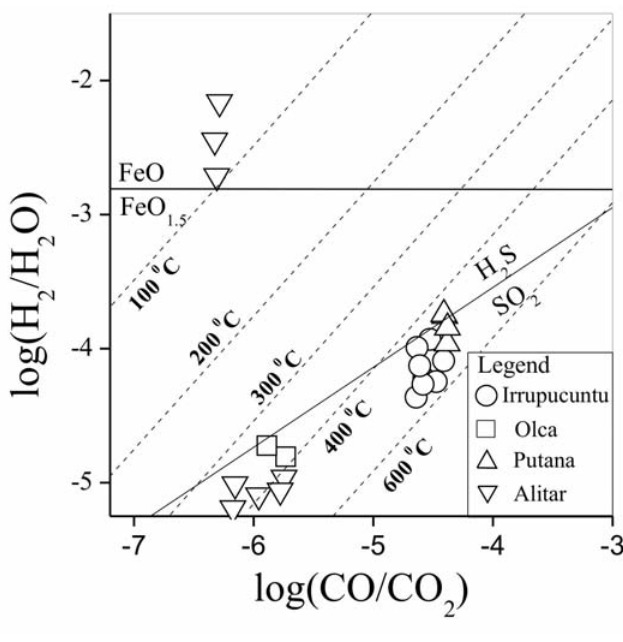
Figure 10. Log(H /H O) versus log(CO/CO ) diagram. Solid lines refer to 2 2 2 equilibria controlled by the FeO-FeO and the SO -H S redox pairs. 1.5 2 2 Dashed lines are the calculated isotherms for the simultaneous equilibrium -H O and the CO-CO geothermometers. Symbols as in legend of the H 2 2 2 to Figure